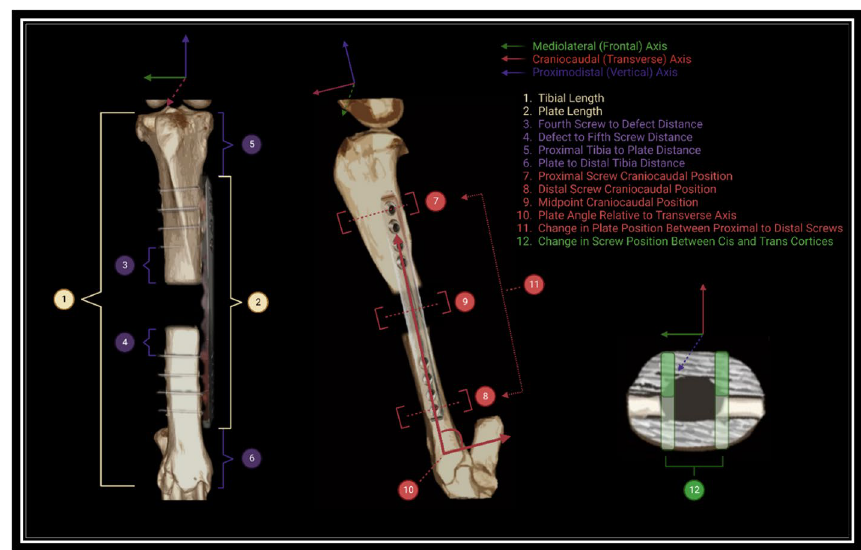
Fig. 3 Diagram of tibial axes and measurements included in plate characteristics and positioning variables. Distances were measured in millimeters from calibrated radiographic or computed tomographic data. Positions were calculated as ratios of calibrated distances, and angles were calculated from calibrated distances and known constants. Image created using